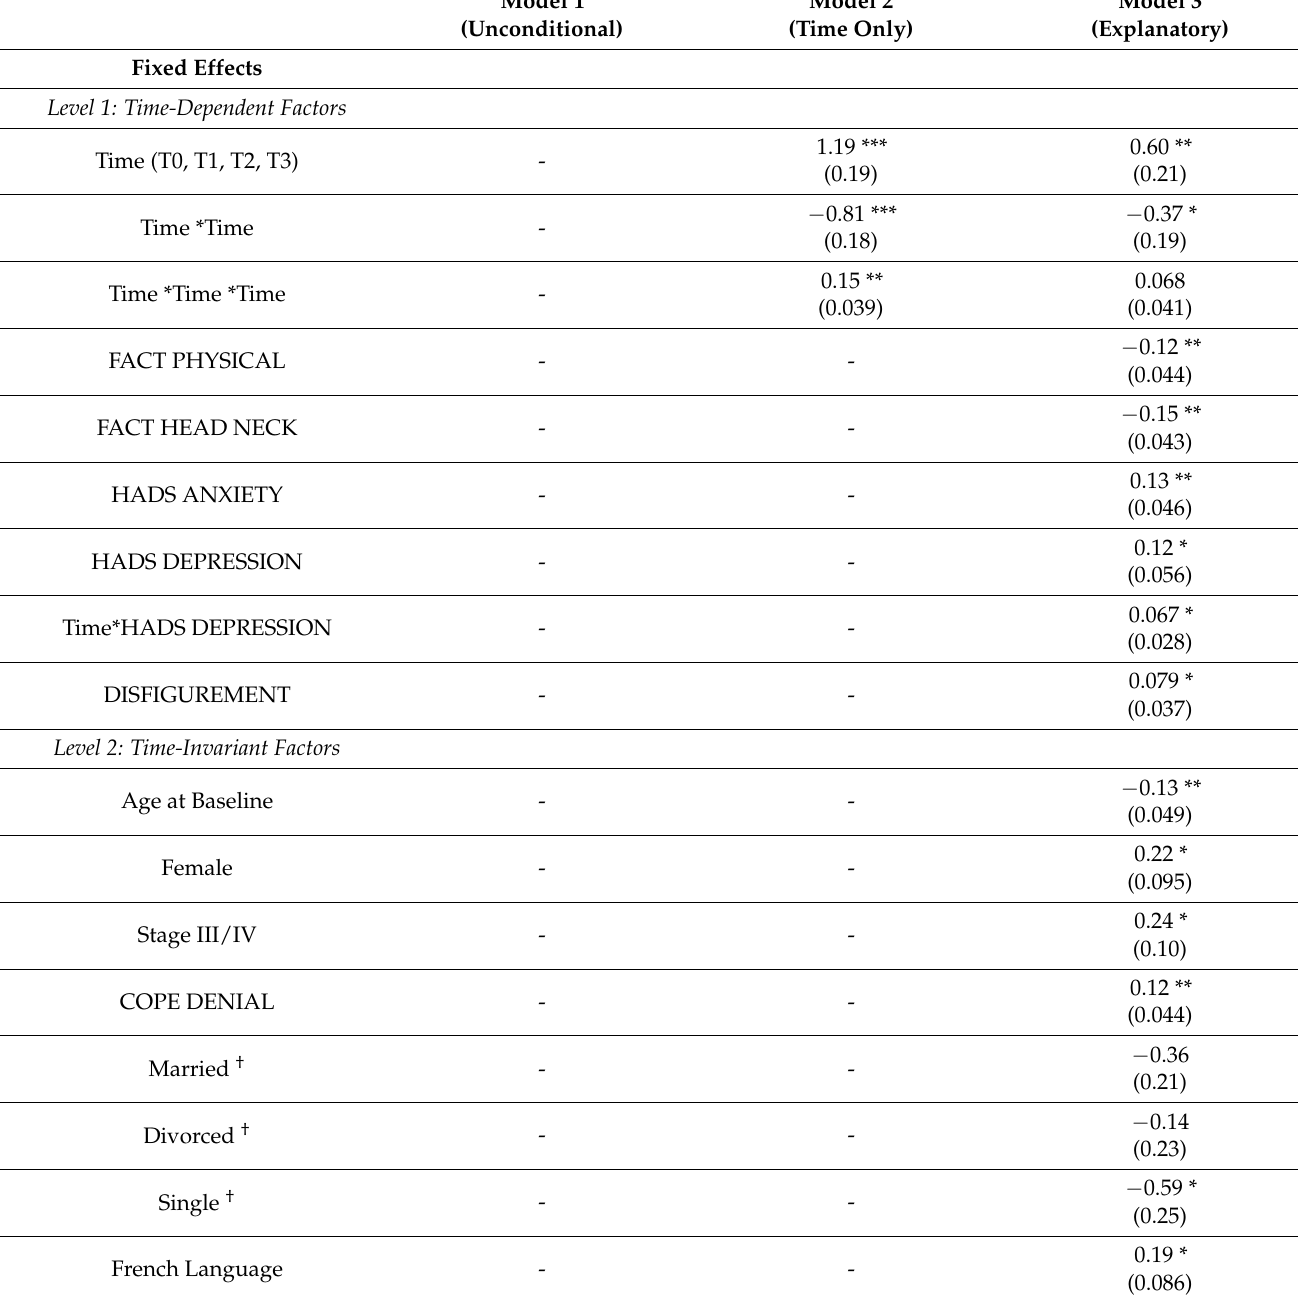
Table 2. Standardized Estimates (and Standard Errors) from 2-Level Growth Models Examining Changes in Body Image in Patients with Head and Neck